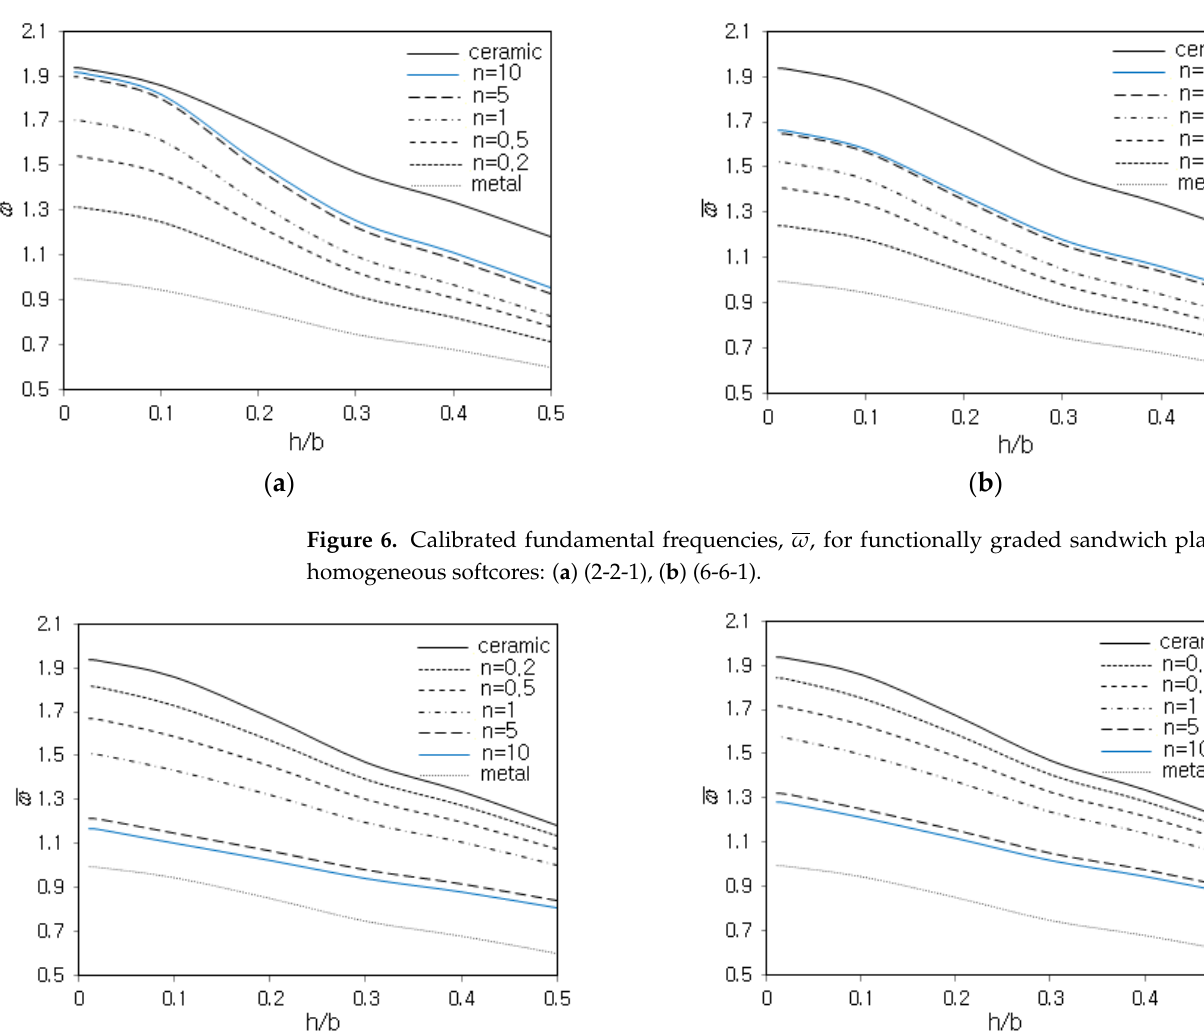
ω Figure 7. Calibrated fundamental frequencies, , for functionally graded sandwich plates with Figure 7. Calibrated fundamental frequencies, ω , for functionally graded sandwich plates with homogeneous hardcores: ( a ) (2-2-1), ( b ) (6-6-1). homogeneous hardcores: ( a ) (2-2-1), ( b ) (6-6-1). Figure 8a,b represent the calibrated fundamental frequencies versus the volume